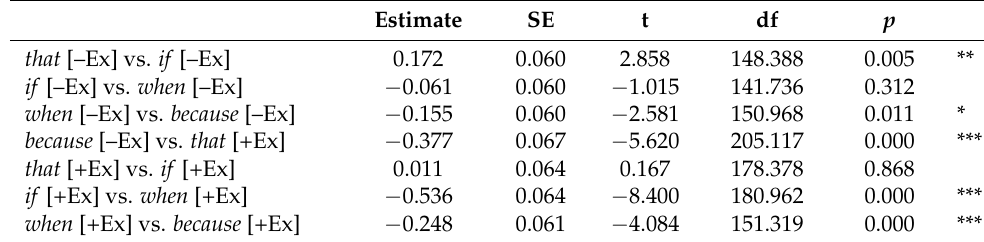
Table 6. Summary of the mixed effects model with sliding contrasts for the z -transformed ratings of the target sentences (adjunct islands). Significance indicators: *** p < 0.001, ** p < 0.01, * p < 0.05.